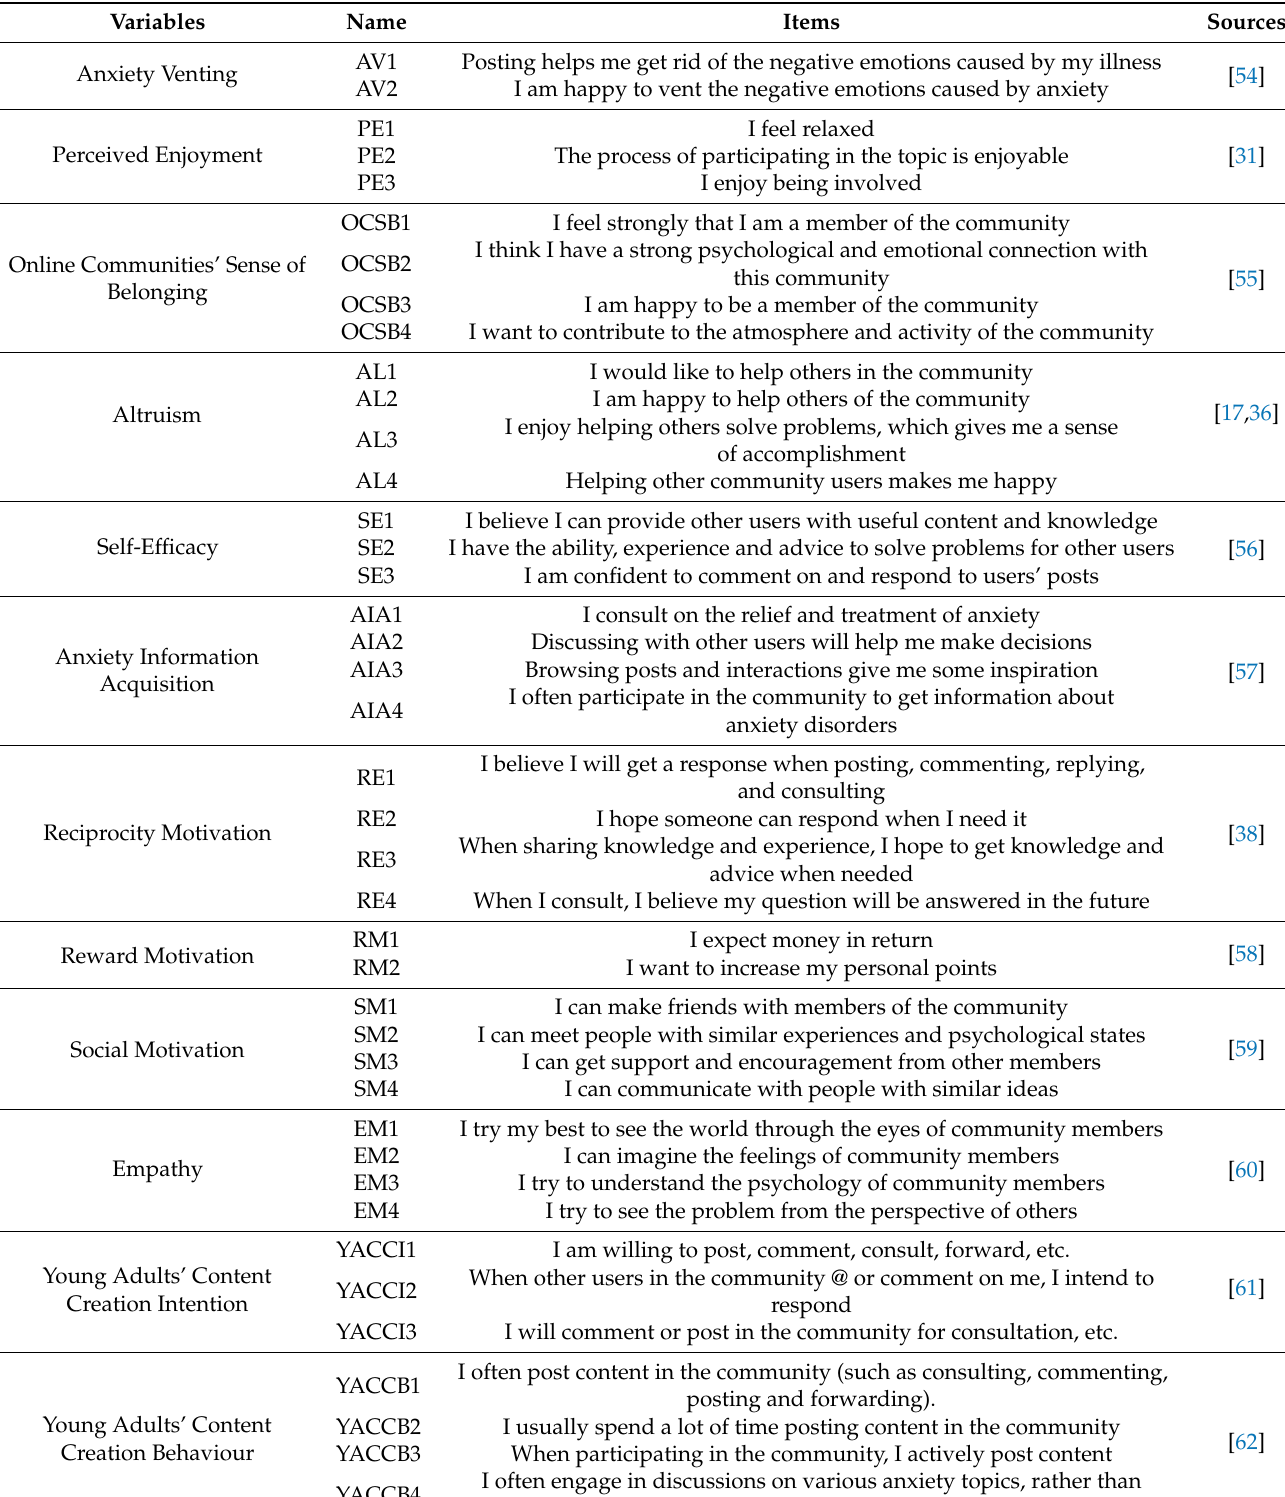
Table 1. Questionnaire variables, items, and